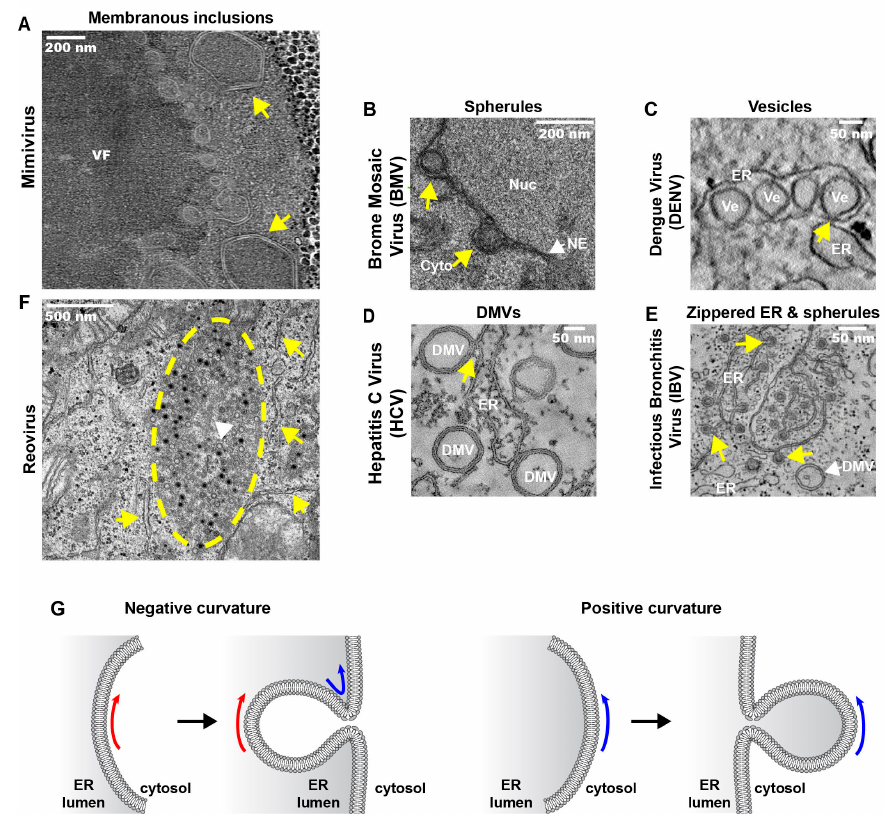
Figure 3. Representative electron micrographs of specialized virus ‐ induced ER modifications. ( A ) Cytoplasmic viral factory (VF) of Acanthamoeba polyphaga mimivirus, 8 hpi, showing icosahedral capsids (yellow arrows) at the factory periphery; ( B ) The replication factor 1A of brome mosaic virus (BMV) localizes to outer perinuclear ER membranes in yeast cells, where it induces the formation of luminal spherules (yellow arrows) (60–80 nm) between the nucleoplasm (Nuc) and the cytoplasm (Cyto); ( C ) Dengue virus (DENV) induces the formation of invaginations of ER membranes, generating arrays of vesicles (Ve) that are known as vesicle packets (VPs). These vesicles remain connected to the cytosol through 10 nm diameter pores (yellow arrow). Shown are Huh7 cells 24 hpi; ( D ) DMVs are abundantly found in Huh 7.5 cells infected with hepatitis C virus (HCV), 16 hpi. Some of them remain connected to their source organelle, the ER (yellow arrow); ( E ) Zippered ER membranes are found in CK cells infected with the gammacoronavirus infectious bronchitis virus (IBV), 16 hpi. The zippered membranes fold to form individual spherules with a channel connecting the cytosol (yellow arrows). DMVs are also found, but to a lesser extent; ( F ) Membranous inclusions (yellow dashed line) found in HeLa cells infected with the reovirus strain T3 ‐ T1M1, 12 hpi. Rough ER cisternae (yellow arrows) are found surrounding the inclusions that contain many virions and coated microtubuli inside (white arrowhead); ( G ) Schematic representation of membrane curvature types. Negative membrane curvature results in the formation of invaginations towards the ER lumen, generating spherules or luminal vesicles. Positive membrane curvature generates exvaginations of ER membranes towards the cytosol, giving rise to cytoplasmic vesicles, tubules or DMVs. Electron micrographs are reproduced with permission from [76] ( A ), [150] ( B ), [146] ( C , D ) [107] ( E ) and [80] ( F